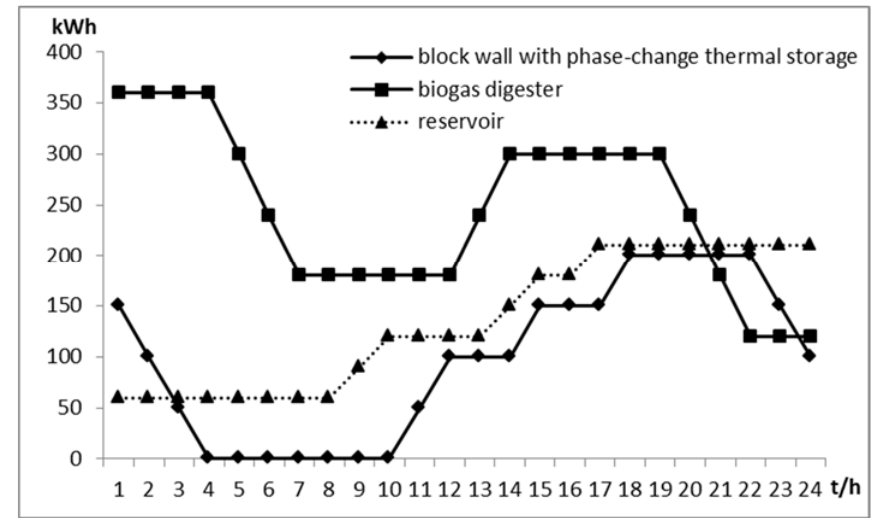
Figure 10. The stored energy curve of energy stores on a winter cloudy day after a sunny day. Table 4. Timetable of loads and energy stores working time before and after optimization on a cloudy winter day after a sunny day.